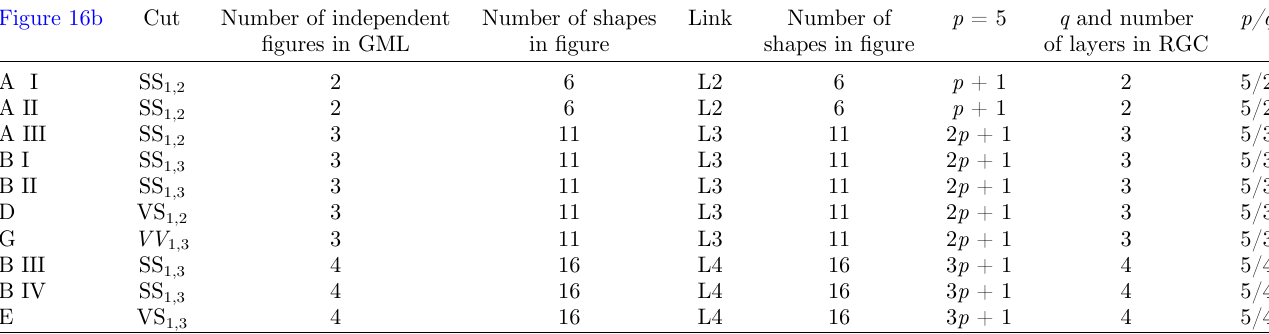
Table 6. GML versus Rational Gielis Curves RGC with m = p / q . Figure 16b